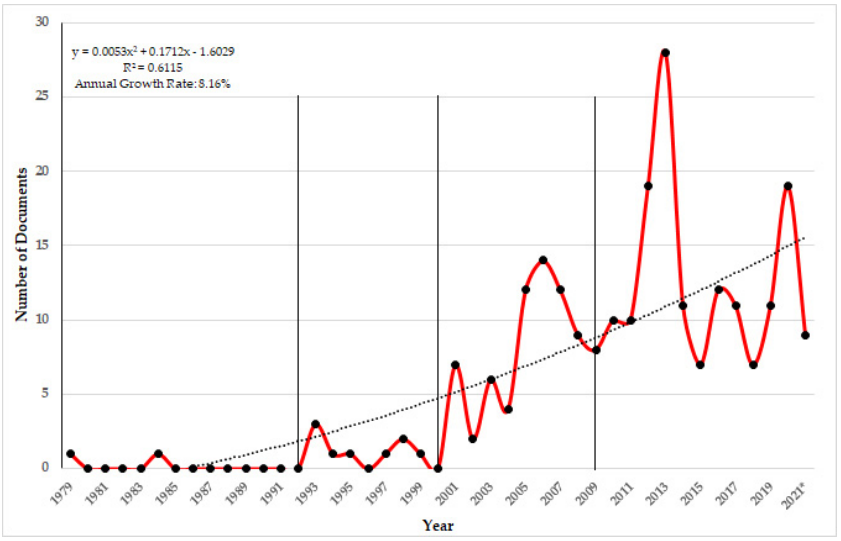
Figure 2. Temporalities of scientific production on Business Improvement Districts (BIDs), 1979– 2021. * Data retrieved in November